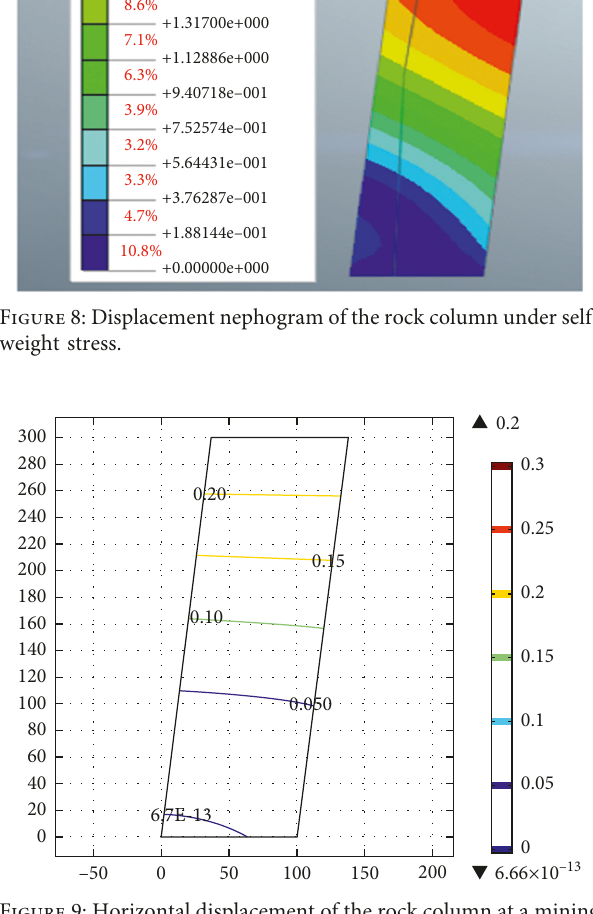
Figure 7: Stress distribution nephogram of the rock column under self-weight stress.